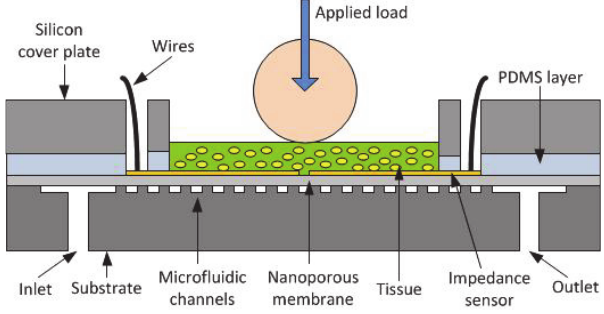
Fig. 1: Schematic of the microfluidic system with integrated bioimpedance sensor. Not to